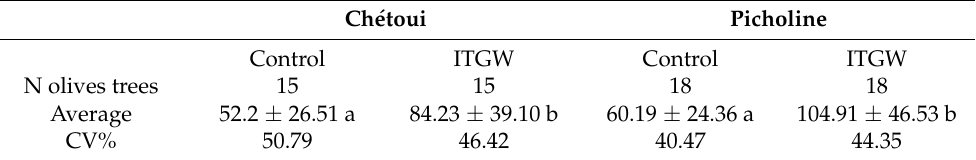
Table 4. Average olive production of two varieties, Ch é toui and Picholine, under irrigation with TGW.